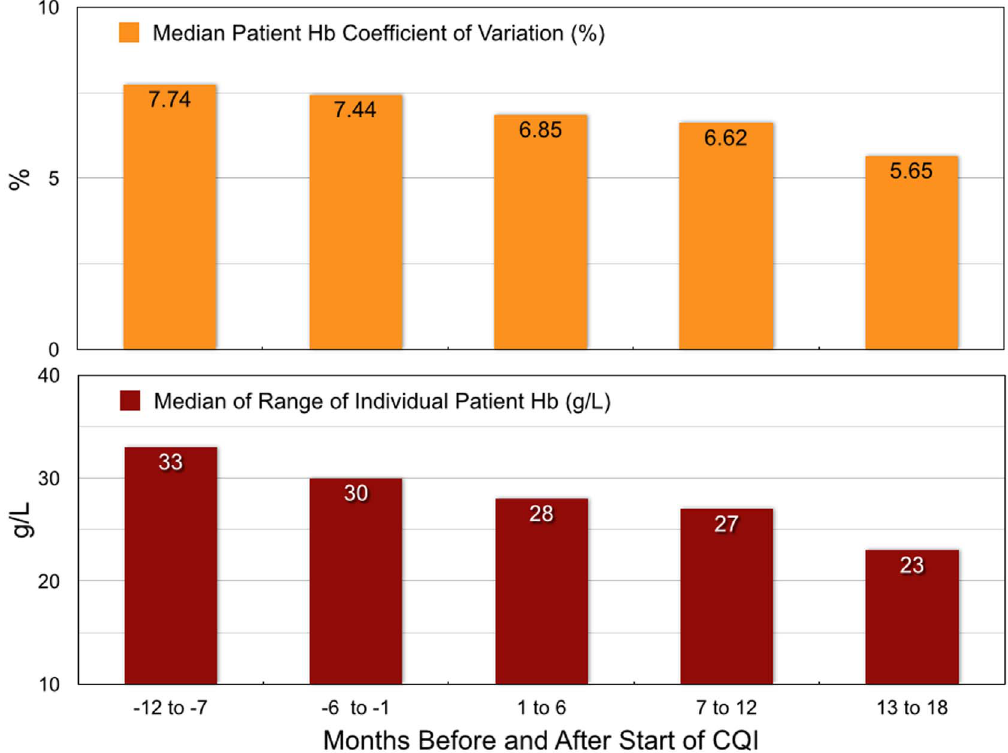
Figure 7. Patient median Hb coefficients of variation and median Hb ranges for two 6-month periods before and three 6-month periods after the start of the CQI process.